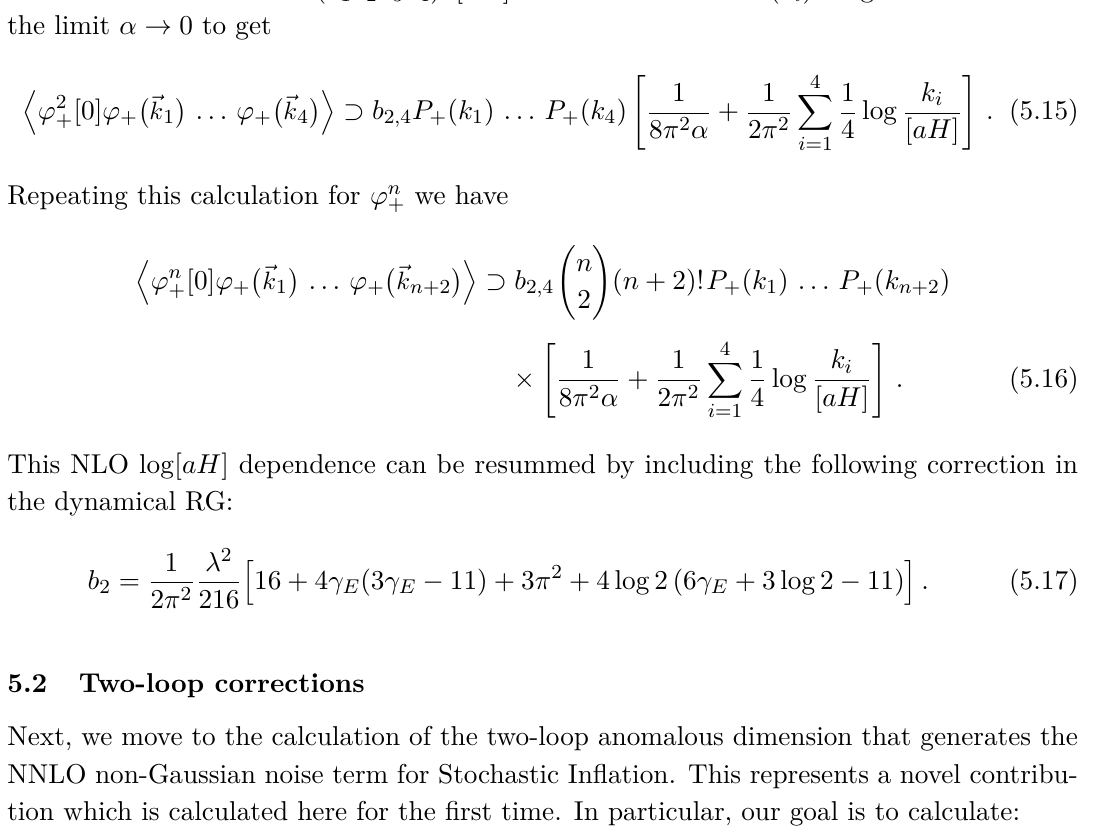
Figure 5 . Diagram of contribution one loop contribution to Γ 2 , 4 ( ϕ 2 the tree level pentaspectrum (6 points function) and integrate over two of the fields to form the composite operator ϕ 2 . Left: the Witten diagram with a boundary at future infinity. Right: the + Feynman diagram with the same momentum